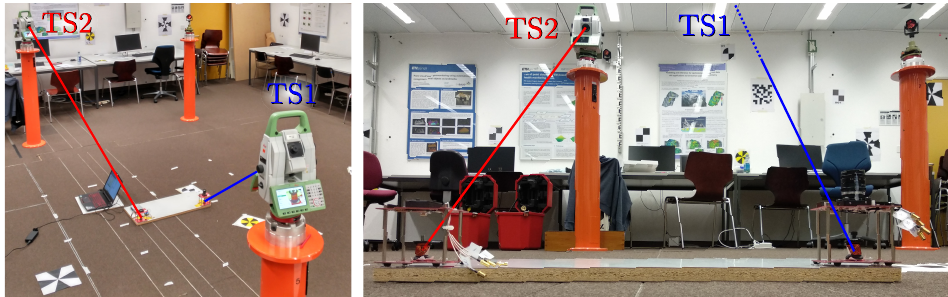
Figure 7. Rotation angle measurements using two Leica TS60 total stations.